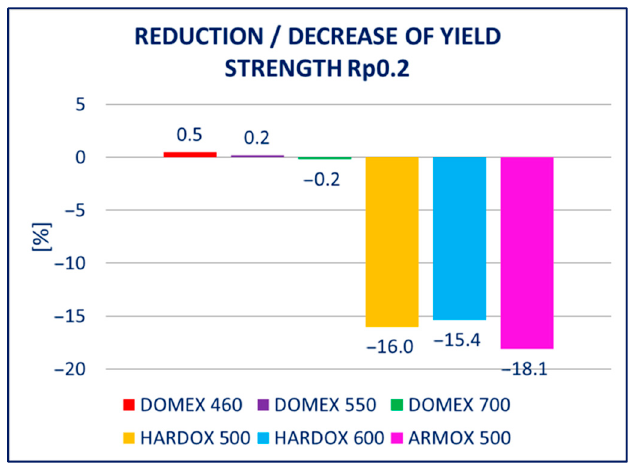
Figure 17. Summary of the results for the yield strength tests presented in the Results section: relative change in R p0.2 for the different types of steel.